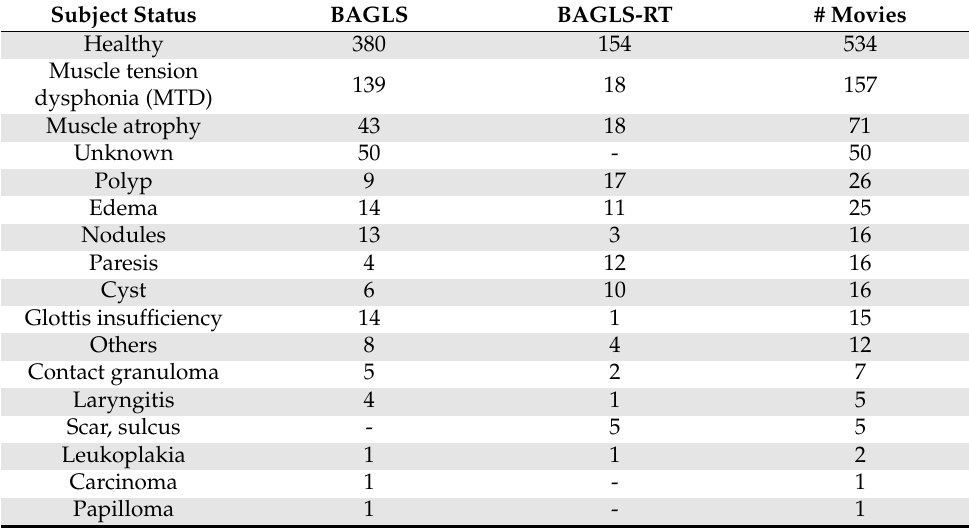
Table A6. Overview of subjects by